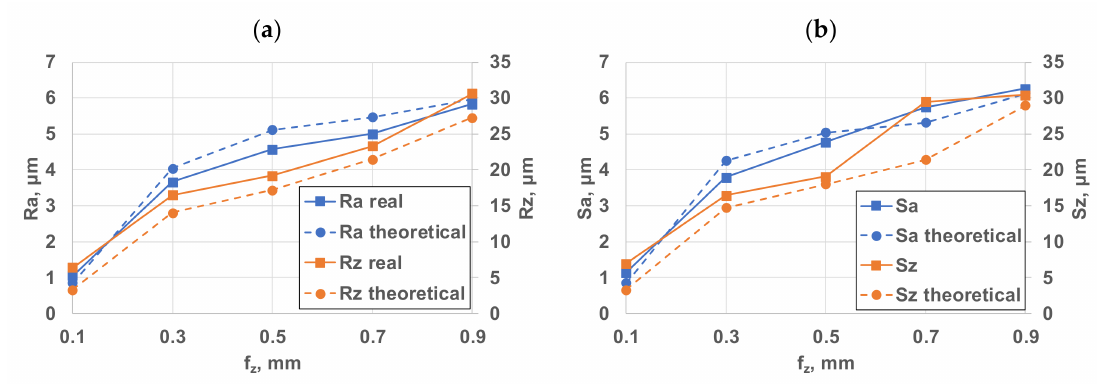
Figure 7. Comparison diagrams of four-insert roughness: ( a ) 2D roughness parameters; ( b ) 3D roughness